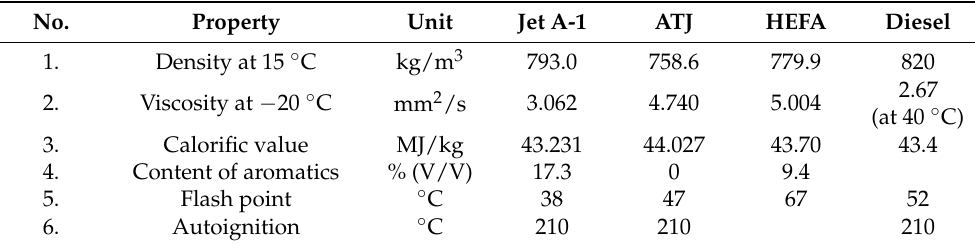
Table 1. Selected physicochemical properties of the fuels